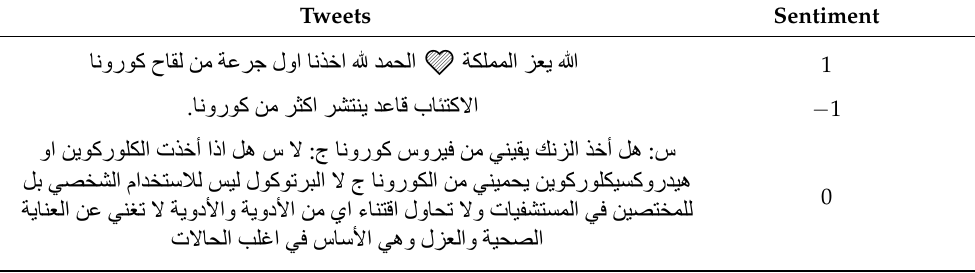
Table 2. Examples of annotated tweets in period during COVID-19.